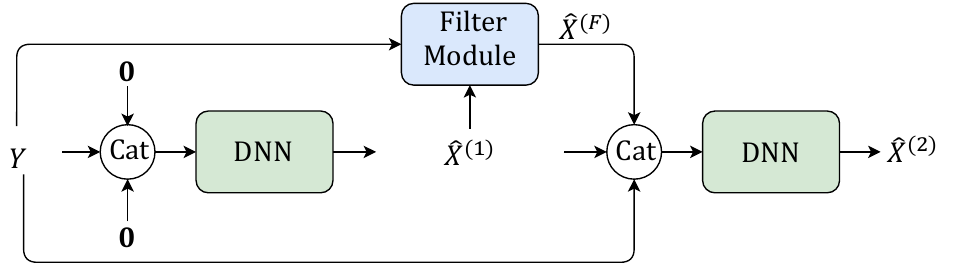
Figure 4. The framework of the system with a single DNN.